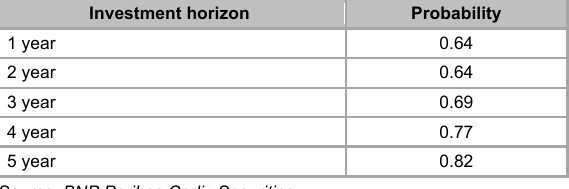
Probability of achieving the CPI+4 per cent target over various investment horizons (January 1971 to December 2010). Investment horizon